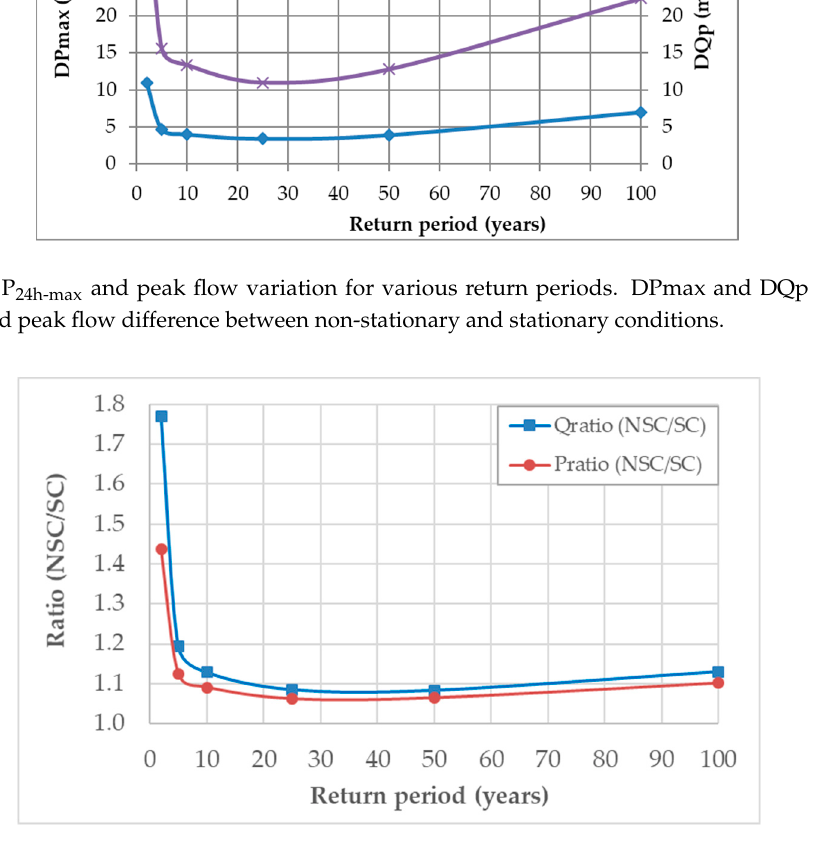
Figure 12. P 24h-max and peak flow ratio variation for various return periods. Qratio and Pratio are the ratio of non-stationary to stationary values of peak flow and P 24h-max respectively.